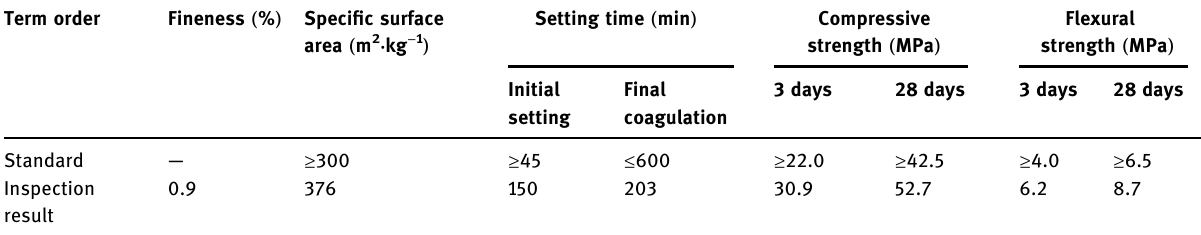
Table 2: Physical properties of cement